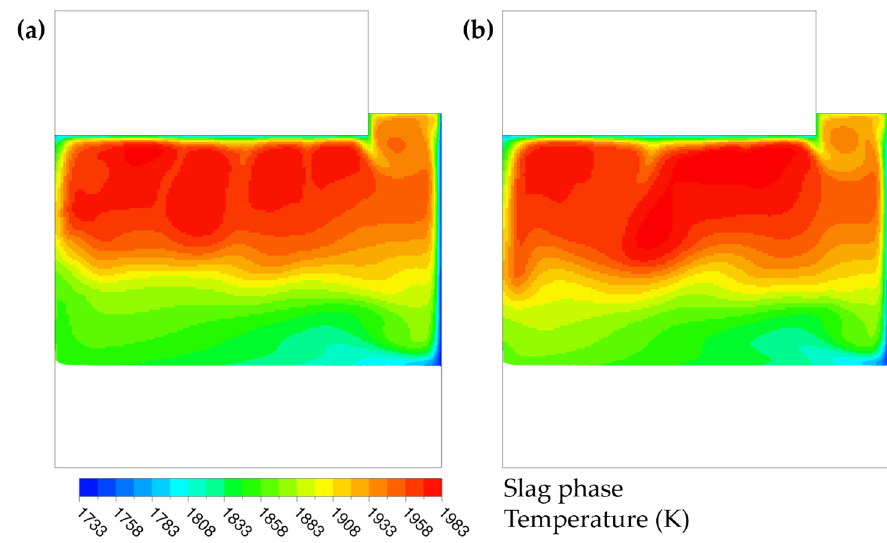
Figure 7. Temperature distribution of the slag phase (time-averaged) for the case without drops ( a ) and considering the drops fall ( b ).